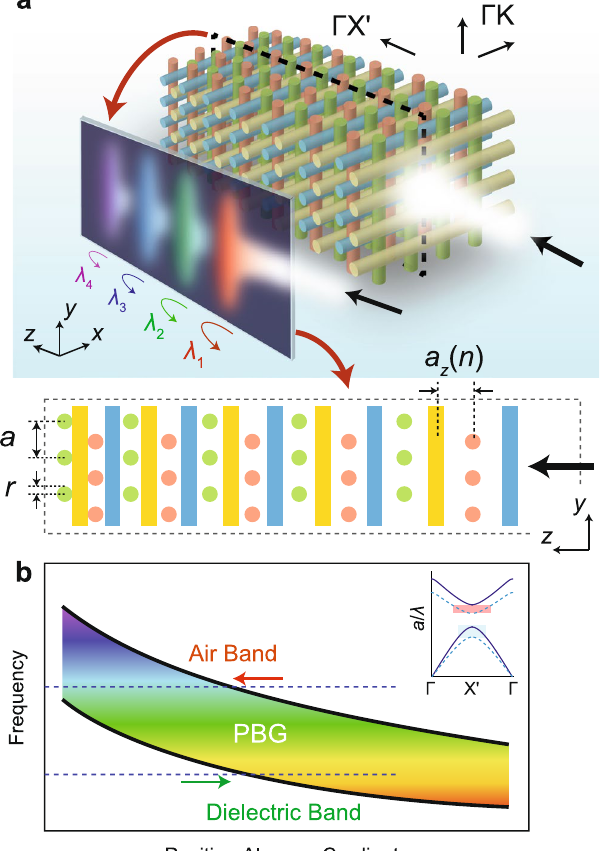
Figure 1. Proposed 3D PhC configuration for rainbow trapping. ( a ) Schematic illustration of the chirped woodpile PhC structure. For better visualization the number of periods of the illustrated PhC structure is reduced. The lower inset depicts the cross sectional view of the structure in the yz- plane. ( b ) The variation of the PBG along the propagation direction is representatively depicted. Due to the gradual variation of the layer-to-layer distances, the incident wave will be spatially separated into its frequency components along the propagation direction, thus forming a “trapped rainbow”, as it is representatively shown as a cross sectional view on the lower left of ( a ). The upper right inset in ( b ) representatively shows the change of the dispersion curves in the propagation direction, where the layer-to-layer distance of the solid black dispersion curve is smaller than that of the dashed blue dispersion curve. The black arrows reveal the propagation direction of the incoming